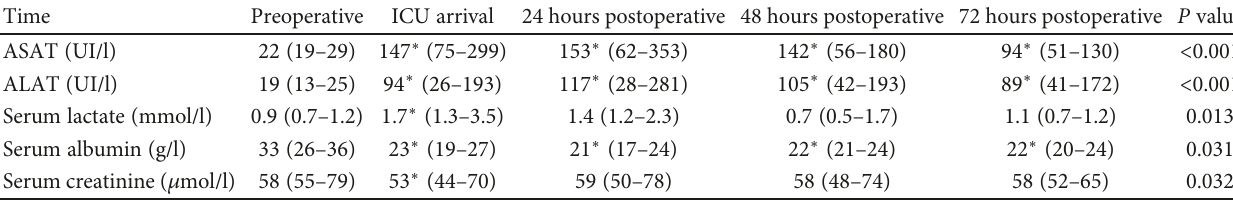
Table 2: Time course of biological data.